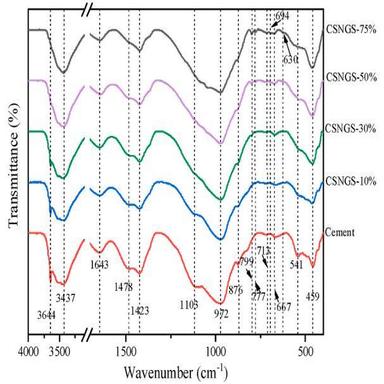
FT-IR spectra of paste with various OPC/CSNGS proportion.